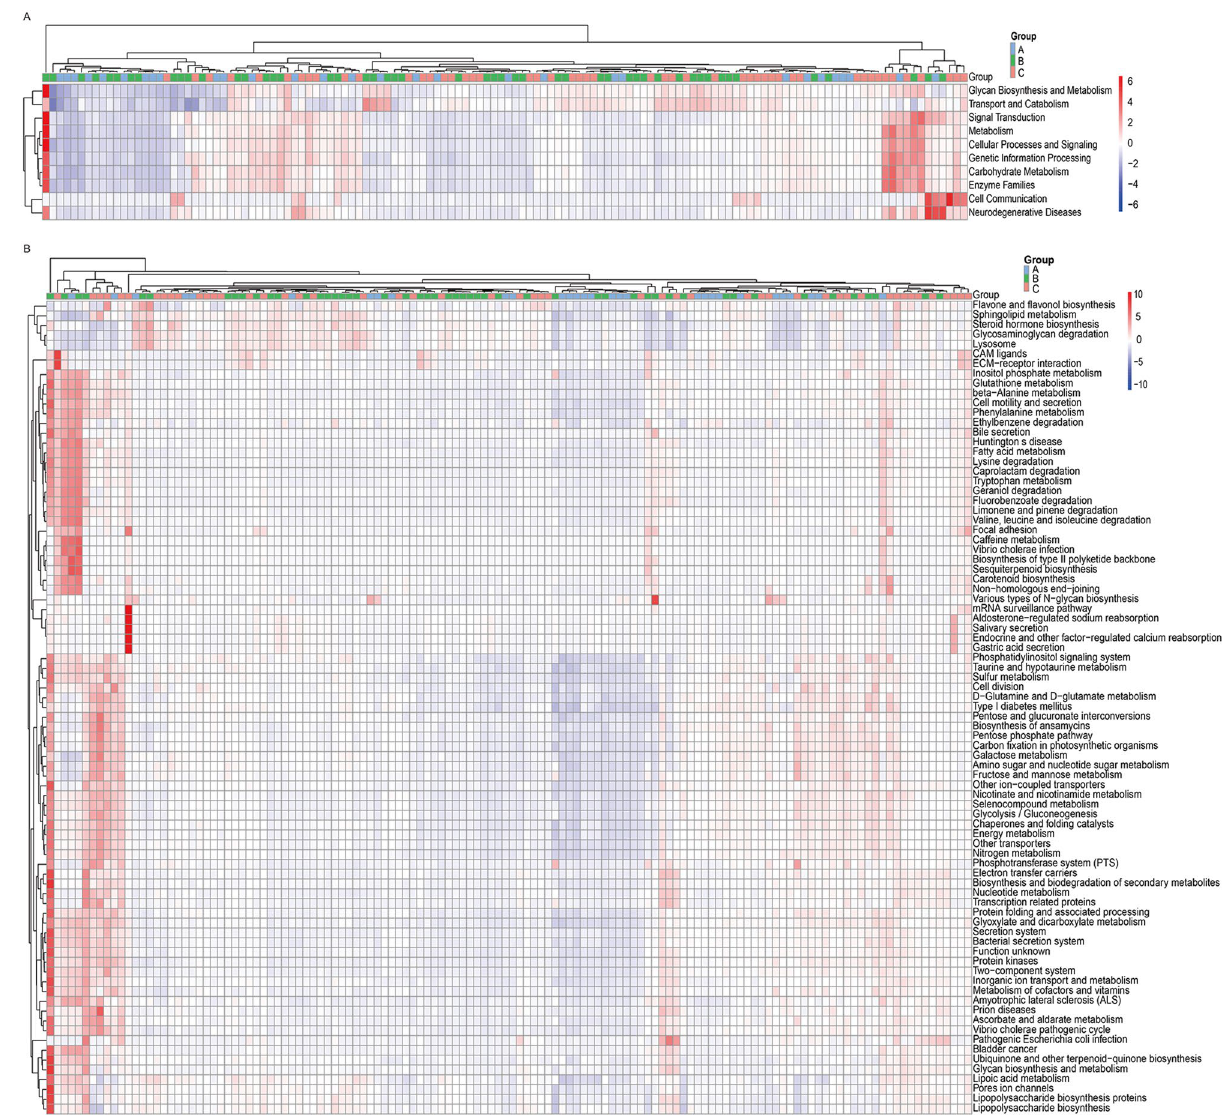
Figure 5. Heatmap of abundance of pathways in KEGG database. Abundance of different pathways based on KEGG (a) level 2 and (b) level 3 in healthy child ( A , n = 30), child with nonwheezing MPP ( B , n = 50), and child with wheezing MPP ( C , n =